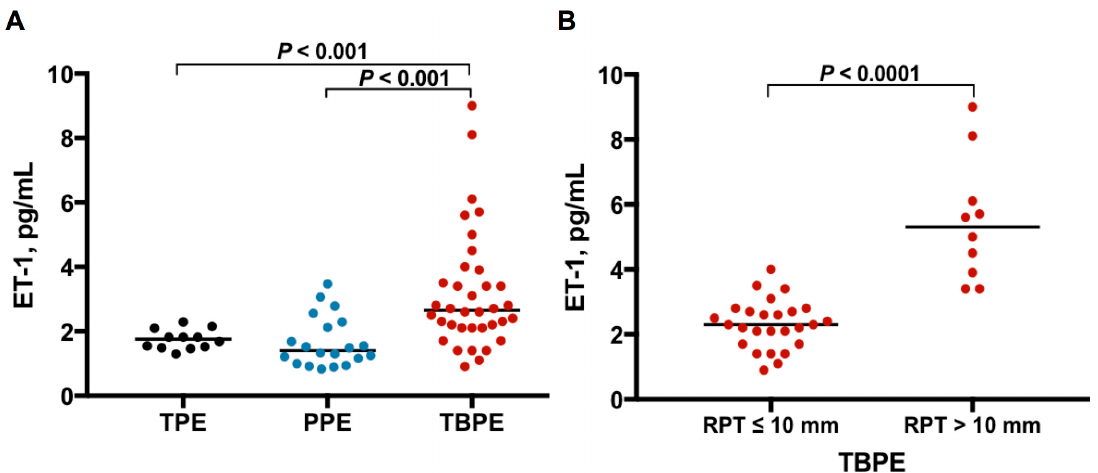
Figure 1. ET ‐ 1 levels among TPE, PPE and TBPE. ( A ) Pleural effusion ET ‐ 1 levels were significantly higher in TBPE than in TPE and PPE. ( B ) Pleural fluid ET ‐ 1 levels were significantly higher in TBPE patients with RPT >10 mm ( n = 10) than in those with RPT ≤ 10 mm ( n = 26). ET ‐ 1, endothelin ‐ 1; TPE, transudative pleural effusion ( n = 12); PPE, parapneumonic pleural effusion ( n = 20); TBPE, tuberculous pleural effusion ( n = 36); RPT, residual pleural thickening.